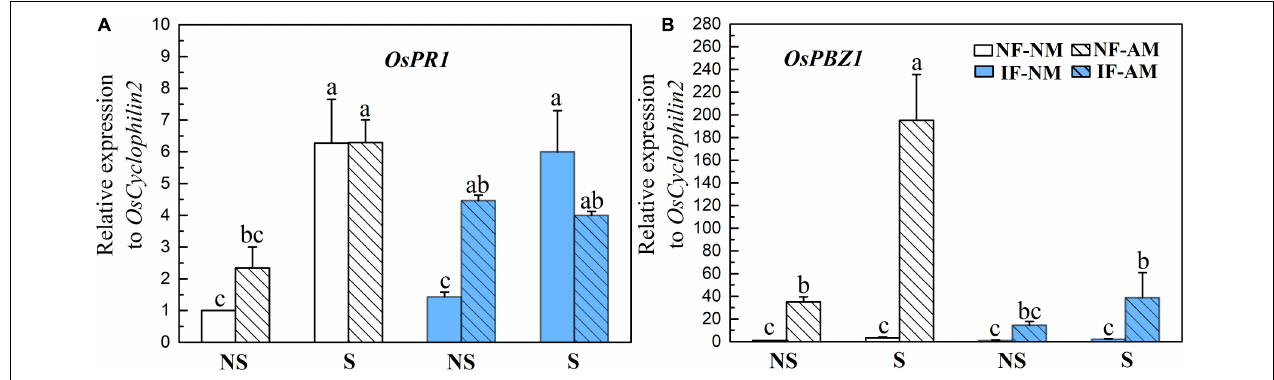
FIGURE 5 | Relative expression levels of defense marker genes OsPR1 (A) and OsPBZ1 (B) in the mycorrhizal (AM) and NM rice roots under different flooding (IF, intermittent flooding, NS, non-flooding) and shading (S, shading, NS, non-shading) conditions in Exp. 2. Guinongzhan (GNZ) was used, and rice plants were harvested at the heading stage. Expression of rice genes are relative to the rice house-keeping gene OsCyclophilin2 . Different letters above the columns indicate significant differences at the P < 0.05 level. Means and standard errors from three replicates are shown.